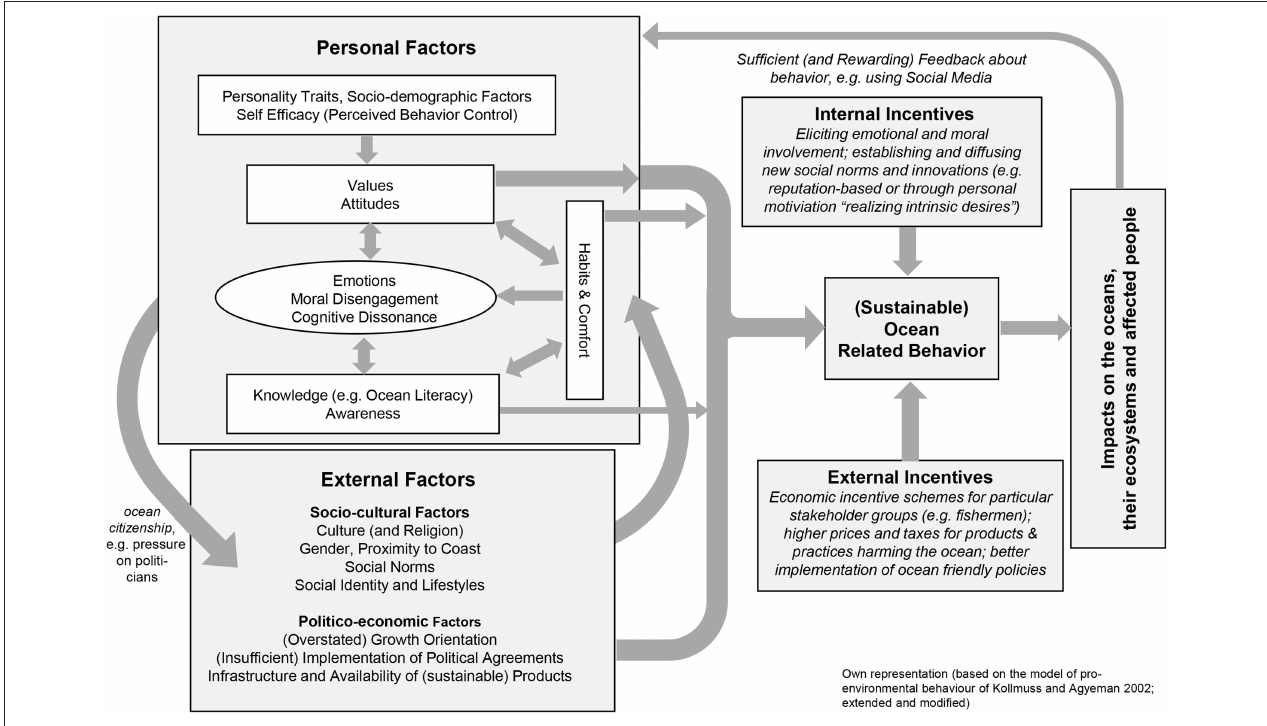
FIGURE 1 | Conceptual model of factors influencing ocean-related sustainable